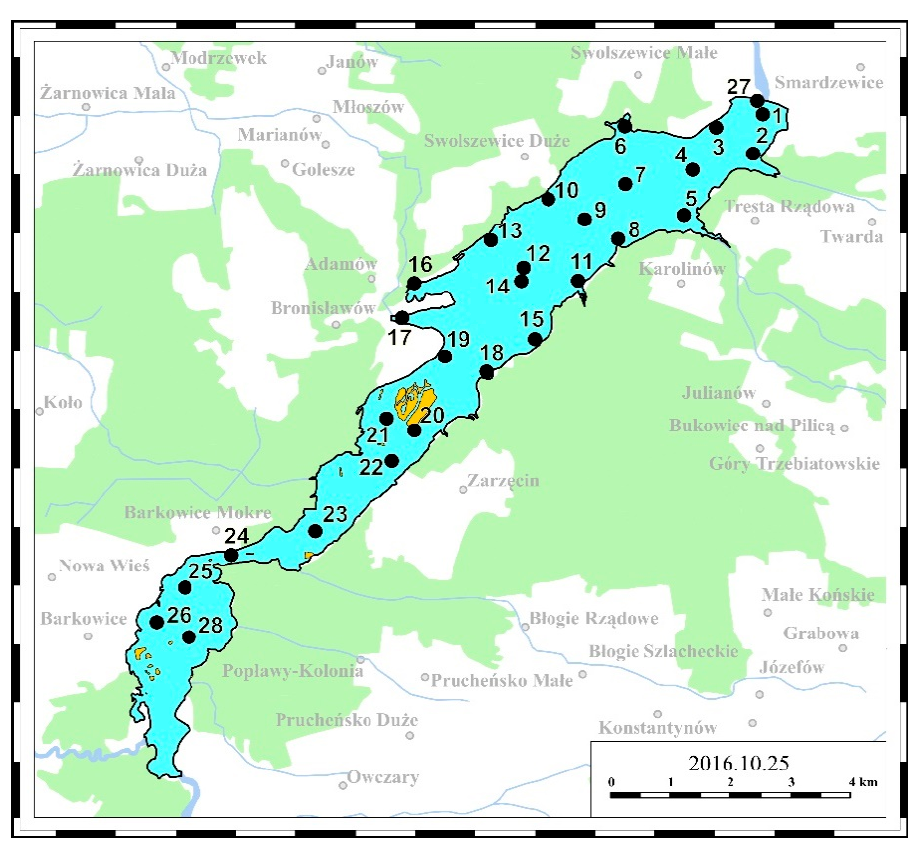
Figure 4 . Location of water sampling points for laboratory tests. Figure 4. Location of water sampling points for laboratory